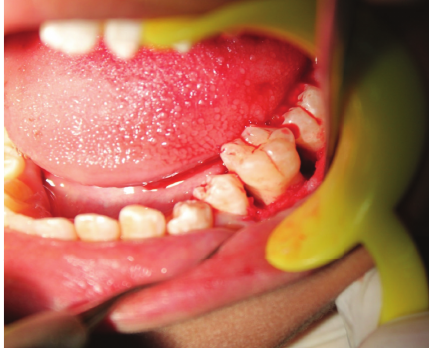
Figure 11: Surgical exploration in relation to 36.